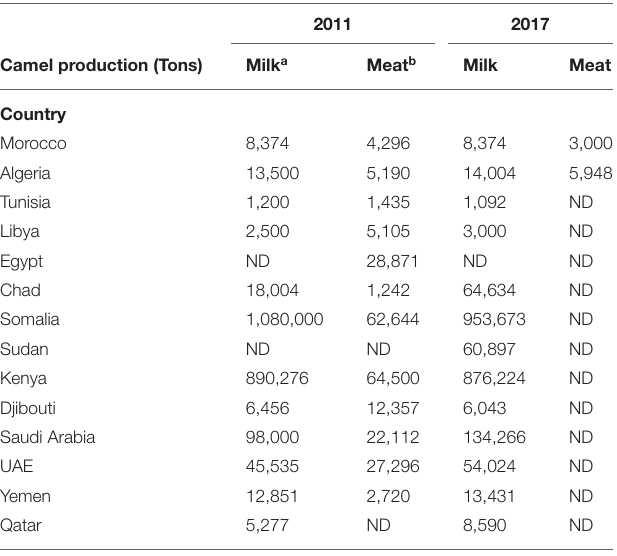
TABLE 5 | Production of whole fresh camel milk and indigenous camel meat in North Africa compared to other countries of Africa and Arabic